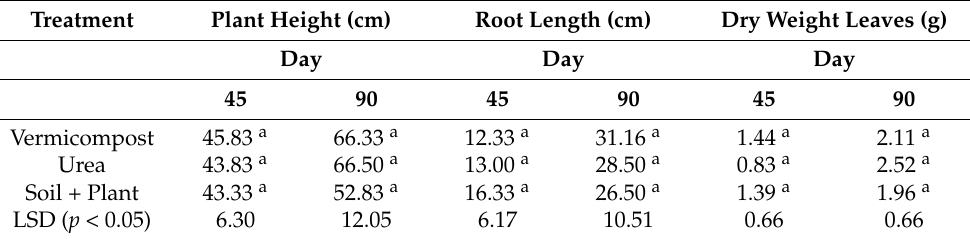
Table 2. Effect of the application of different types of fertilization on the growth parameters of Moringa oleifera